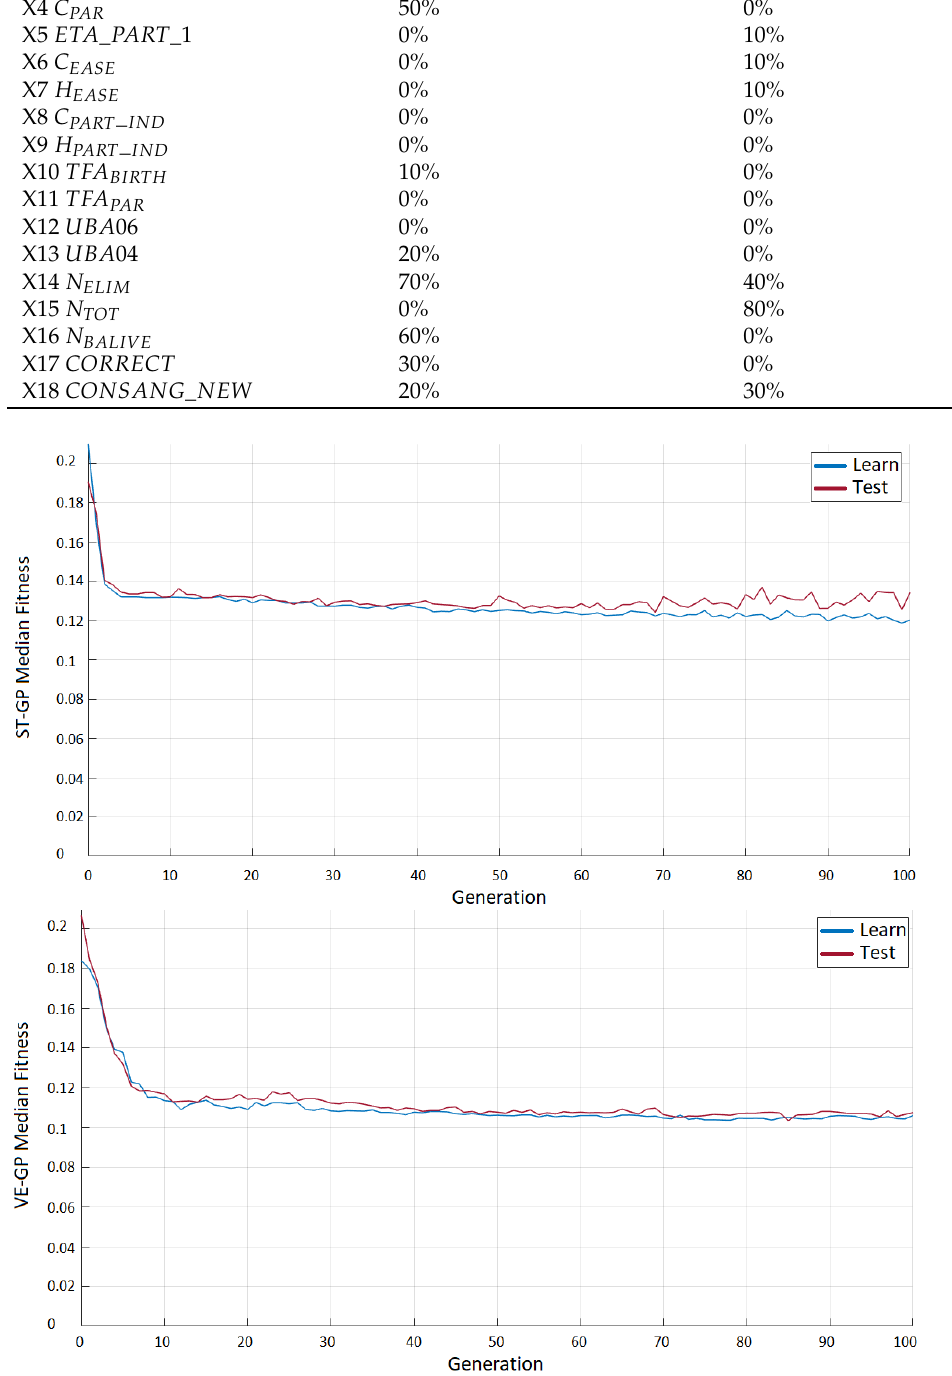
Figure 1. ST-GP ( up ) and VE-GP ( down ) fitness evolution plots. For each generation, the graph plots the median of the 10 median fitness achieved by the best 7 models on the validation sets and correspondingly the performance achieved on the learning and test